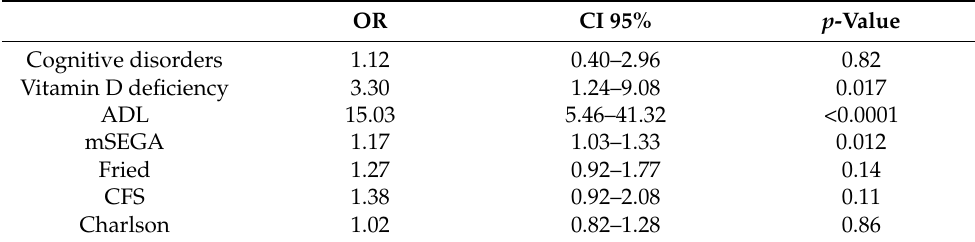
Table 4. Multivariate